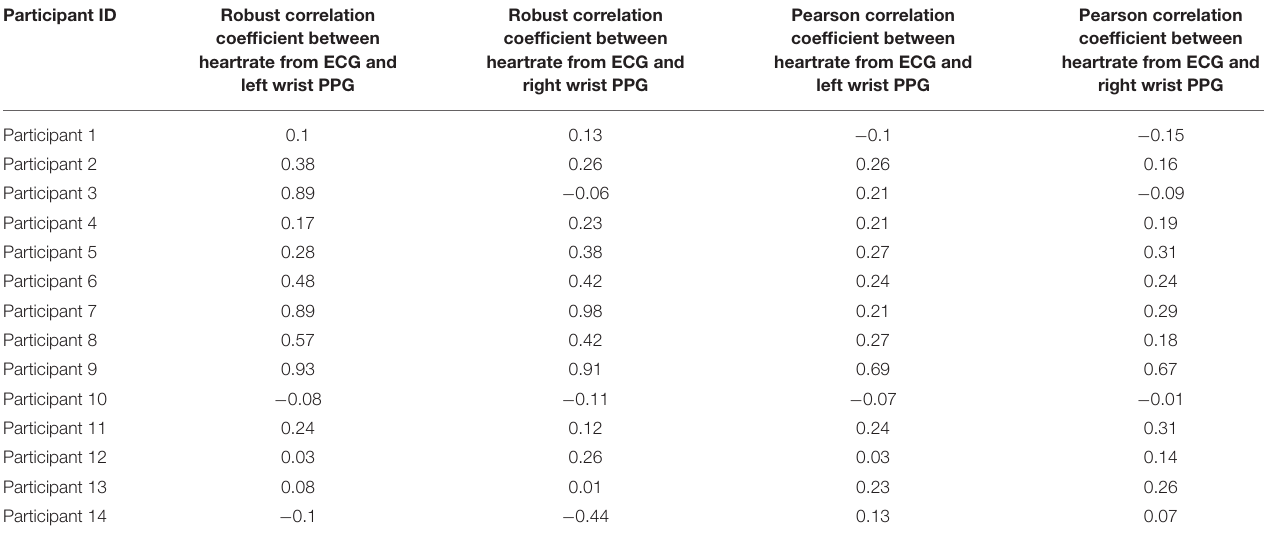
TABLE 4 | Correlation coefficient between PPG and ECG sensors. Participant ID Robust correlation